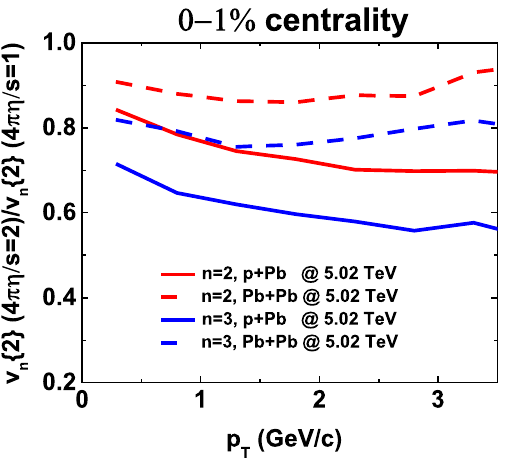
Fig. 6 Theratiobetween v 2 (and v 3 )with η/ s = 1 / 4 π andwith η/ s = 2 / 4 π as a function of p T in 5.02 TeV p + Pb collisions and 5.02 TeV Pb + Pb collisions with same parameters and at 0–1% centrality